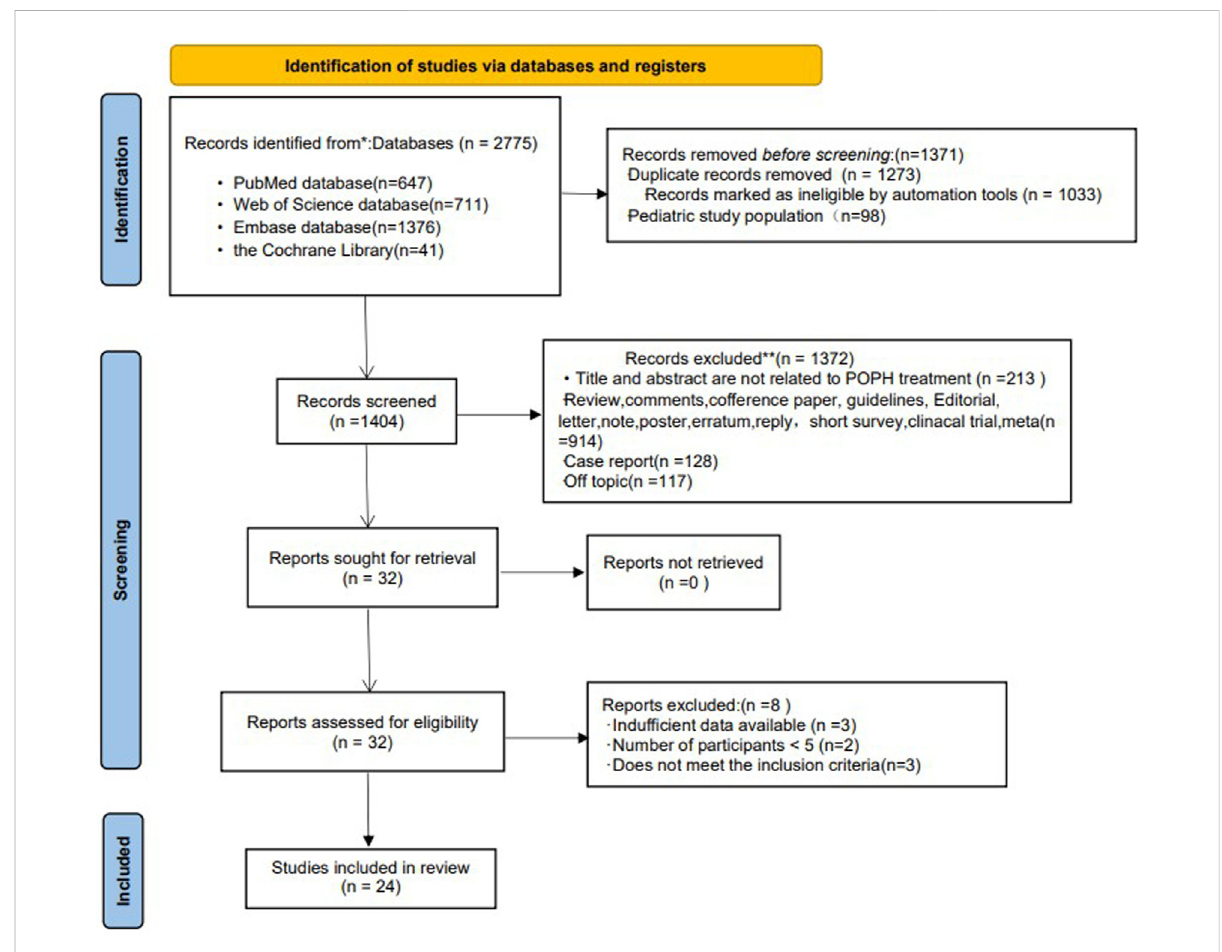
FIGURE 1 Flow chart of the selection of studies for inclusion in the